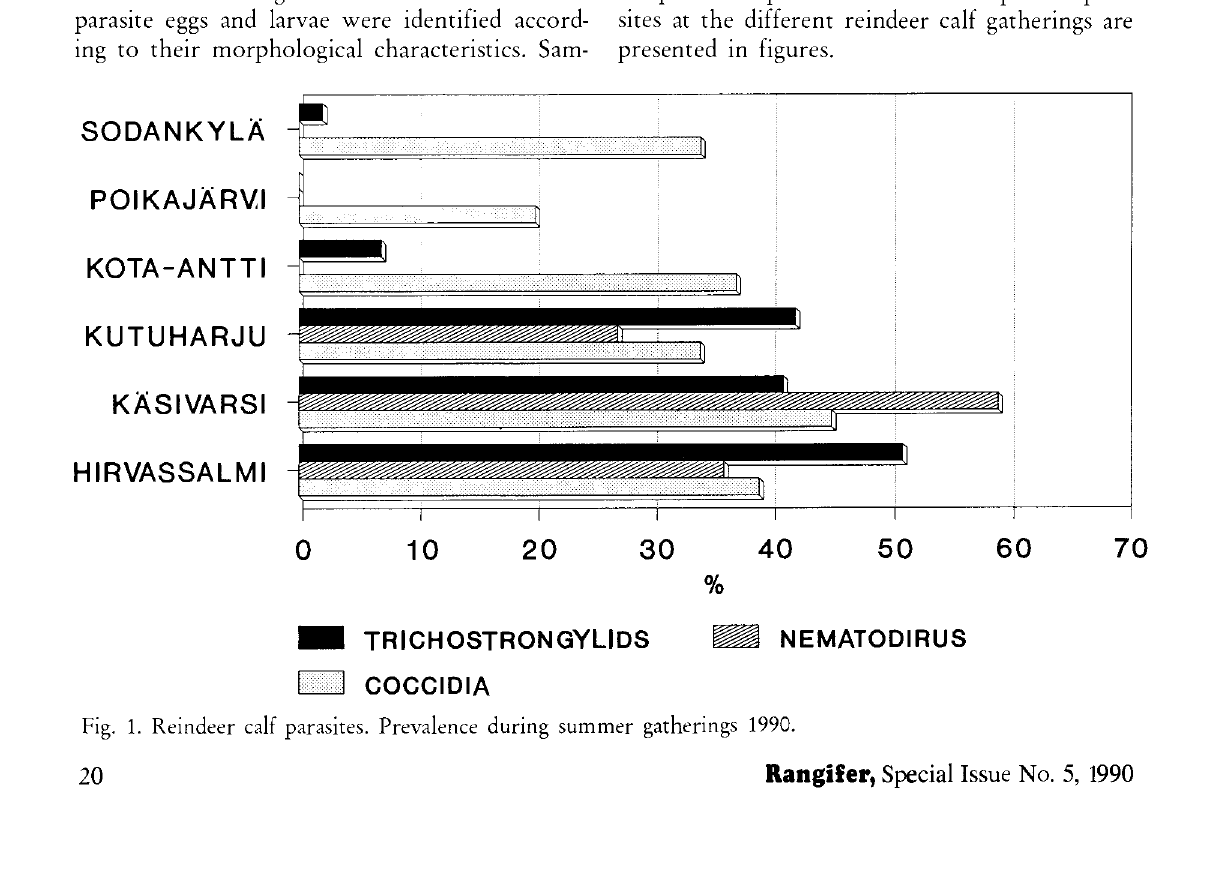
Fig. 1. Reindeer calf parasites. Prevalence during summer gatherings